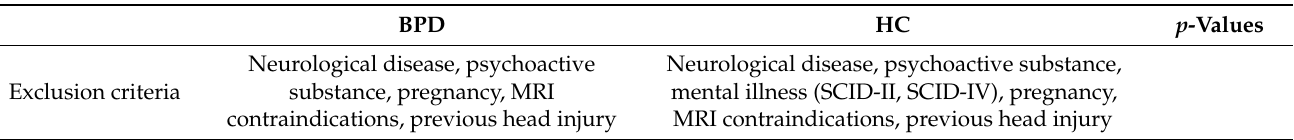
Table 1. Cont. BPD HC p